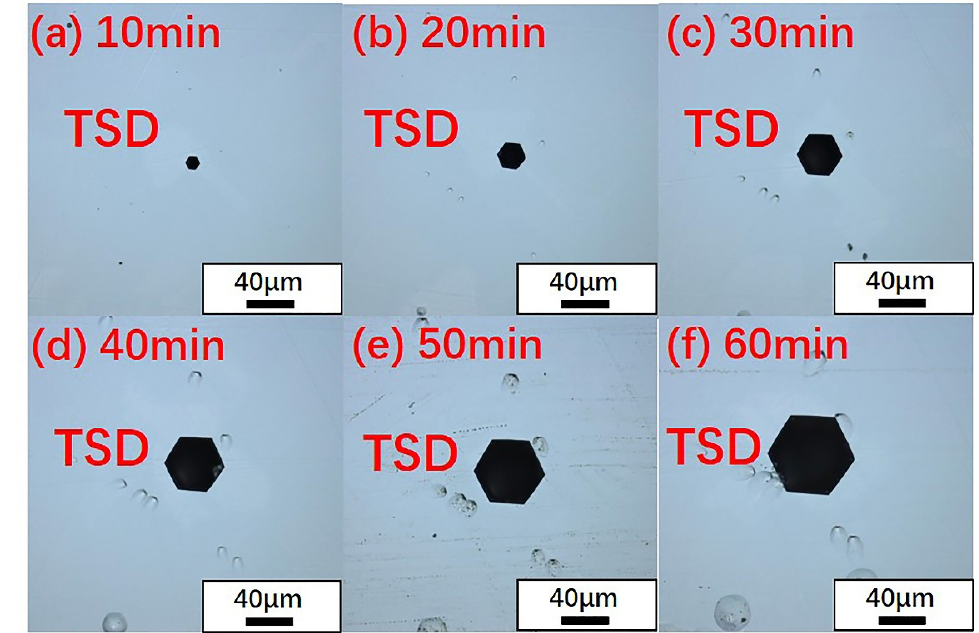
Figure 5. Evolution of the morphology of TSD etch pits with time under a laser confocal micro- scope. ( a ) 10min, ( b ) 20min, ( c ) 30min, ( d ) 40min, ( e ) 50min, ( f ) 60min Table 1. The size difference between 4H-SiC micropipe etch pits and TSDs with etching time.